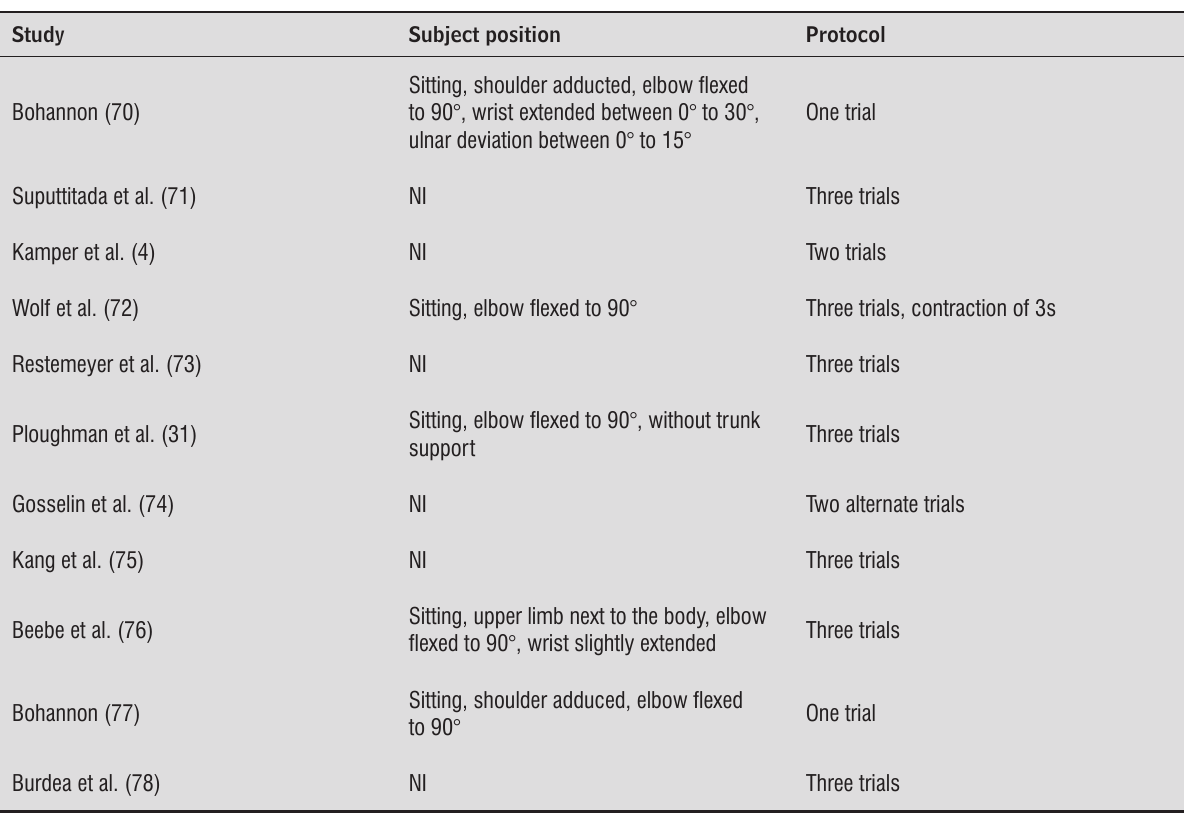
Table 2 - Data extraction of the 24 studies which assessed handgrip strength in subjects with stroke with portable dyna- mometers and provided information regarding the subject’ positioning or the data collection protocol